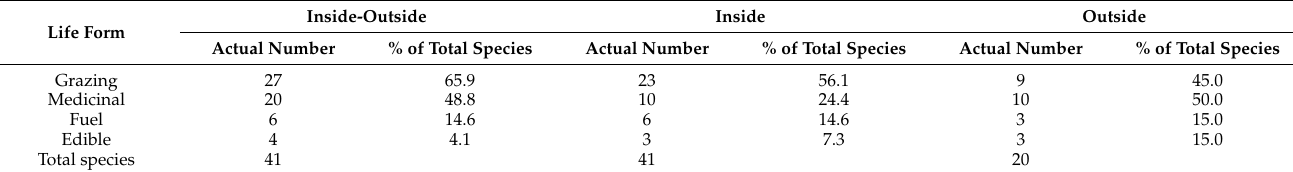
Table 4. Common services offered by the species inside-outside, only inside, and only outside the protected enclosures. Life Form